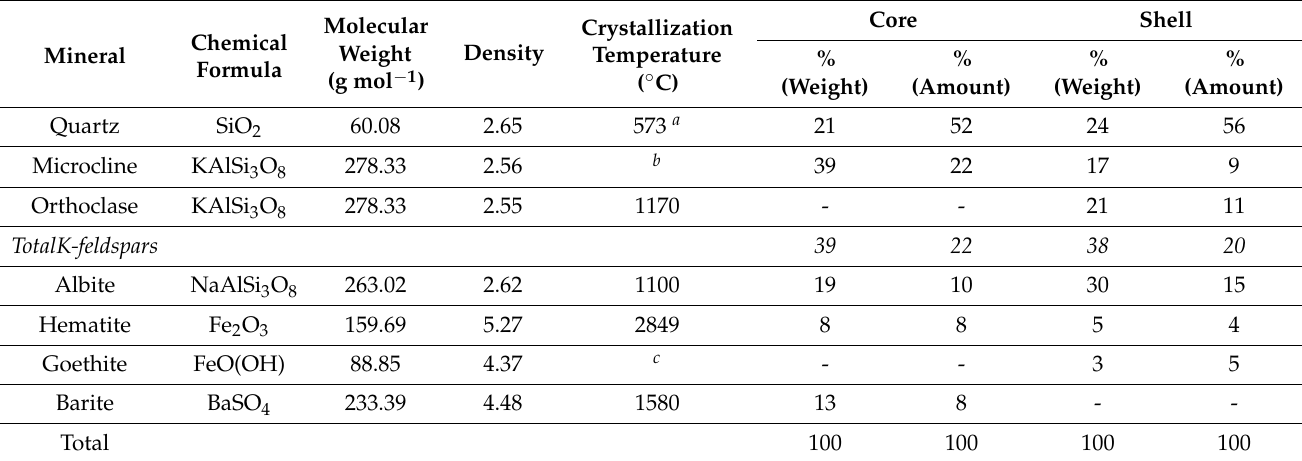
Table 1. Properties, percentage amounts, and weight percentages of the different minerals in the core and shell compartments of the studied fulgurite, as estimated from the XRD experiments.